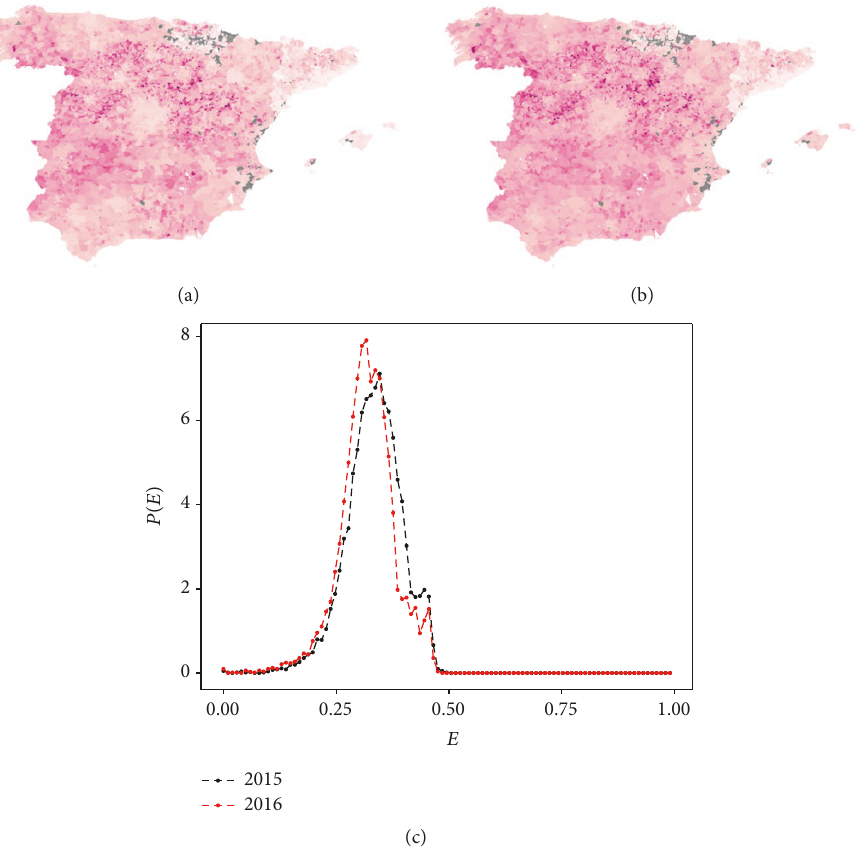
Figure 3: (a, b) Heat maps of the entropy index ( 𝐸 , see the text) at the municipality level (the darker and the lower the entropy is, the more the bipartisansystemis)for2015elections(a)and2016elections(b).Entropyislarger(leadingtomoreheterogeneousvoteandlessbipartisanship) closer to cosmopolite cities (e.g., Madrid and Barcelona). Overall, this index is approximately constant over time ( ⟨𝐸⟩ = 0.34 ± 0.06 in 2015 and ⟨𝐸⟩ = 0.33 ± 0.06 in 2016), similar to the results obtained using the bipartisanship